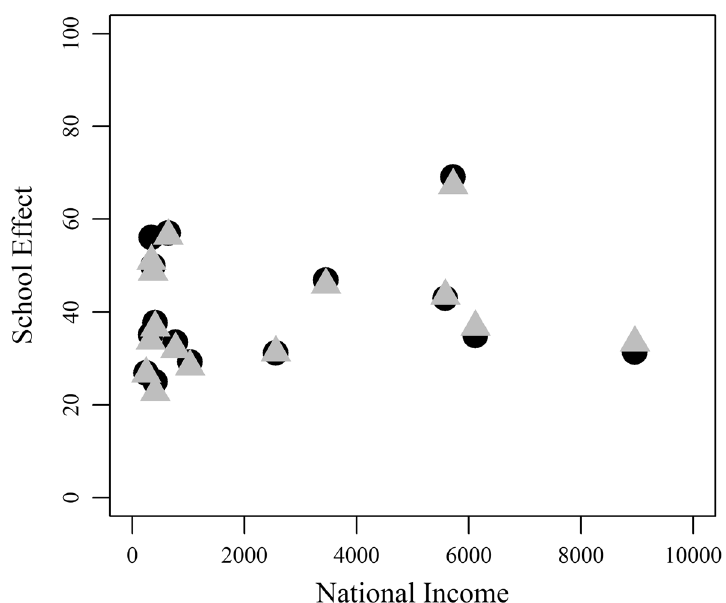
Fig. 5 National income and the school effect for reading. Note. Black points and gray triangles are the naive and correction parameter estimates for the school effect. Both school effects are posterior means